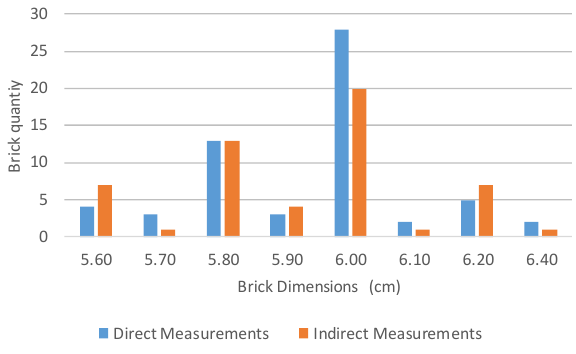
Figure 12. Comparison between direct and indirect measurements carried out on the same area of the bell-tower In Palazzo Trotti, two sample areas have been chosen on the basis of the stratigraphic analysis. The most significant areas are in the central wing. For each USM an area accessible to direct measurement (1D, 2D) has been compared with a corresponding area of the same USM where indirect measures have been taken on the basis of rectified images (1I, 2I), as shown in Figure 13. The masonry is made of bricks and pebbles, so the number of bricks per sample is not very high, but the obtained distributions are significant.